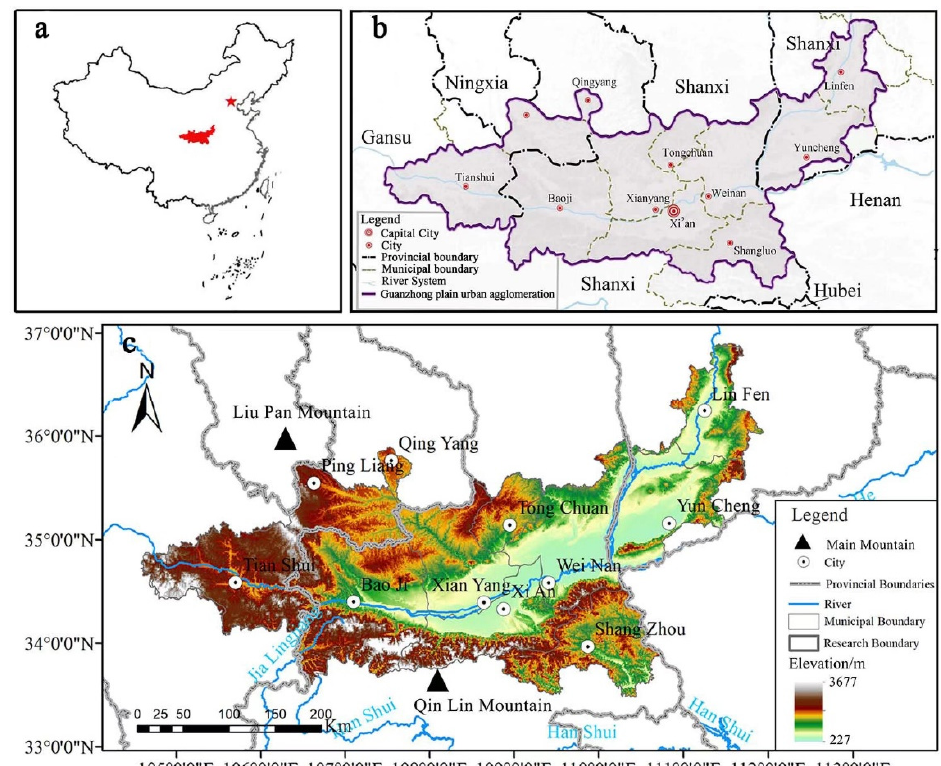
Figure 2. Overview of Guanzhong Plain urban agglomeration: ( a ) location in China; ( b ) administra- tive divisions; ( c ) elevation.